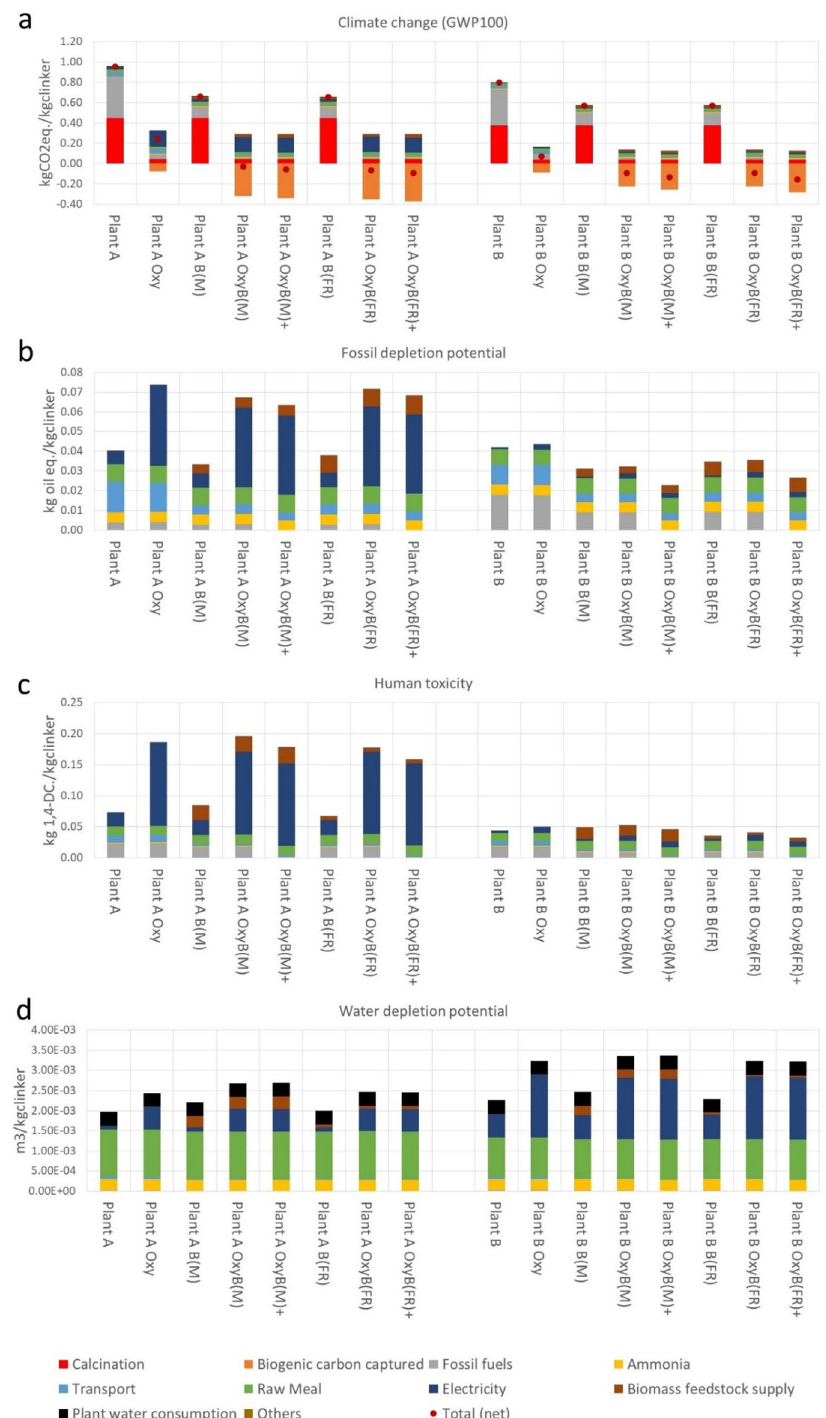
Figure 3. Selected life cycle environmental impact categories for the cement clinker production cases under conventional and oxyfuel CCS (Oxy) with increased use of biomass fuels. Cases indicated with (M) consider biomass supply from miscanthus and (FR) from forest residues. The symbol “ + ” indicates the cases where additional biomass is used to reach 100% of alternative fuels. Impacts on climate change (GWP100) ( a ), fossil depletion potential (FDP) ( b ), human toxicity (HT) ( c ), and water depletion potential (WDP) ( d ). Plant A is located in Germany plant B in Sweden REF represent a reference plant based on average European cement